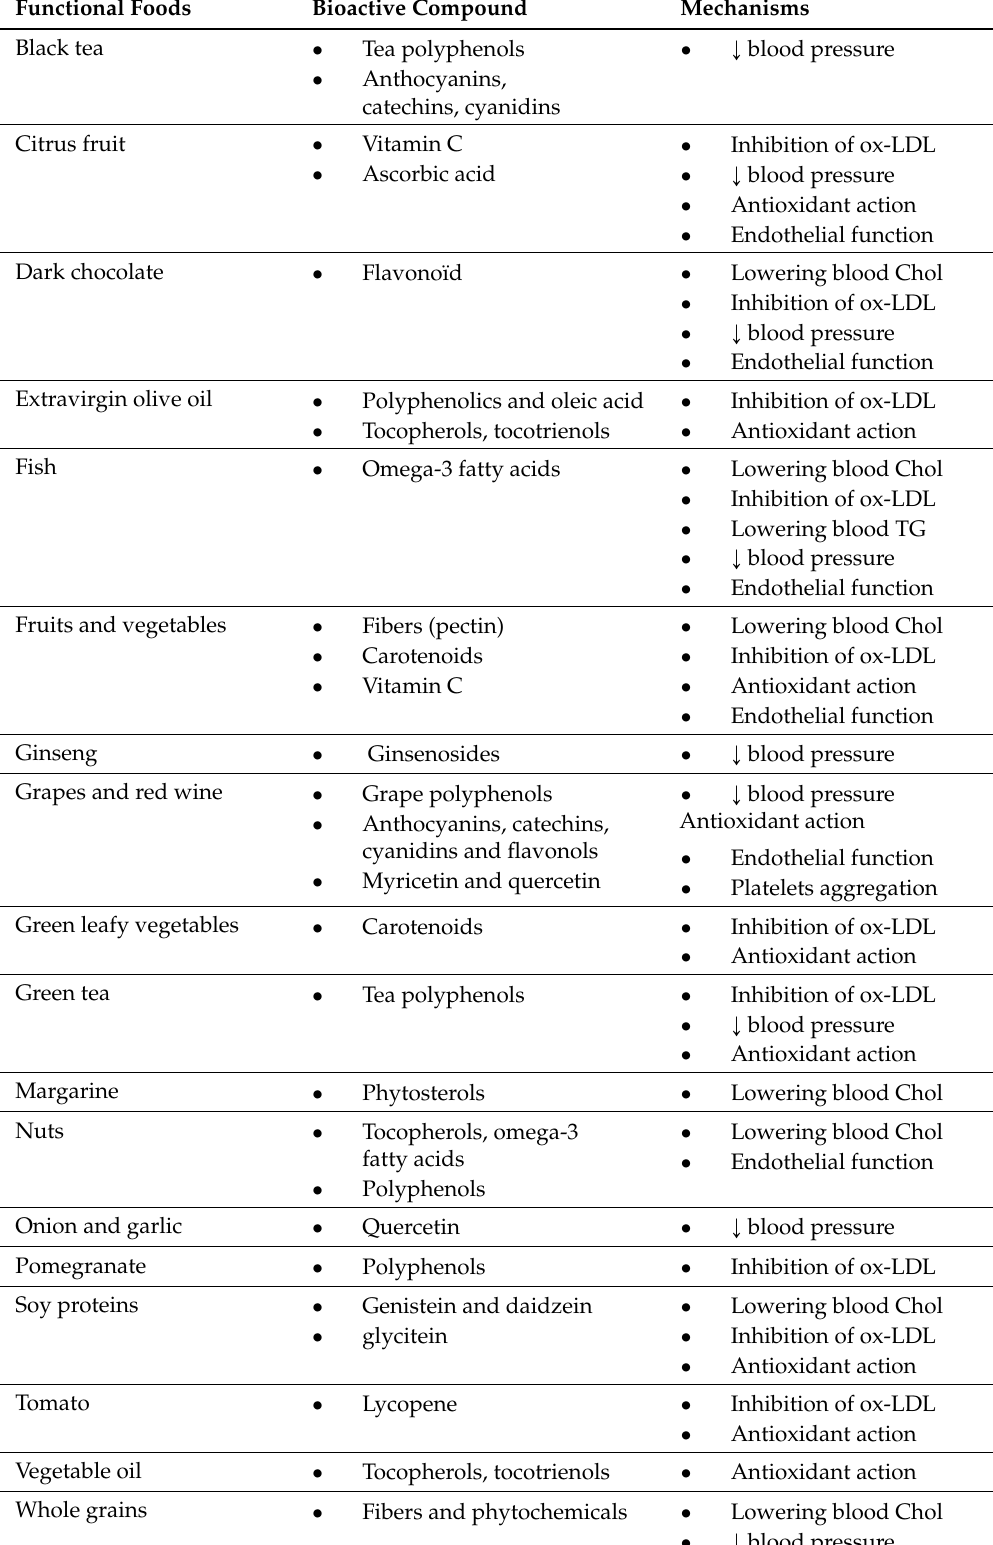
Table 1. Effects of functional foods and their bioactive compound on cardiovascular parameters